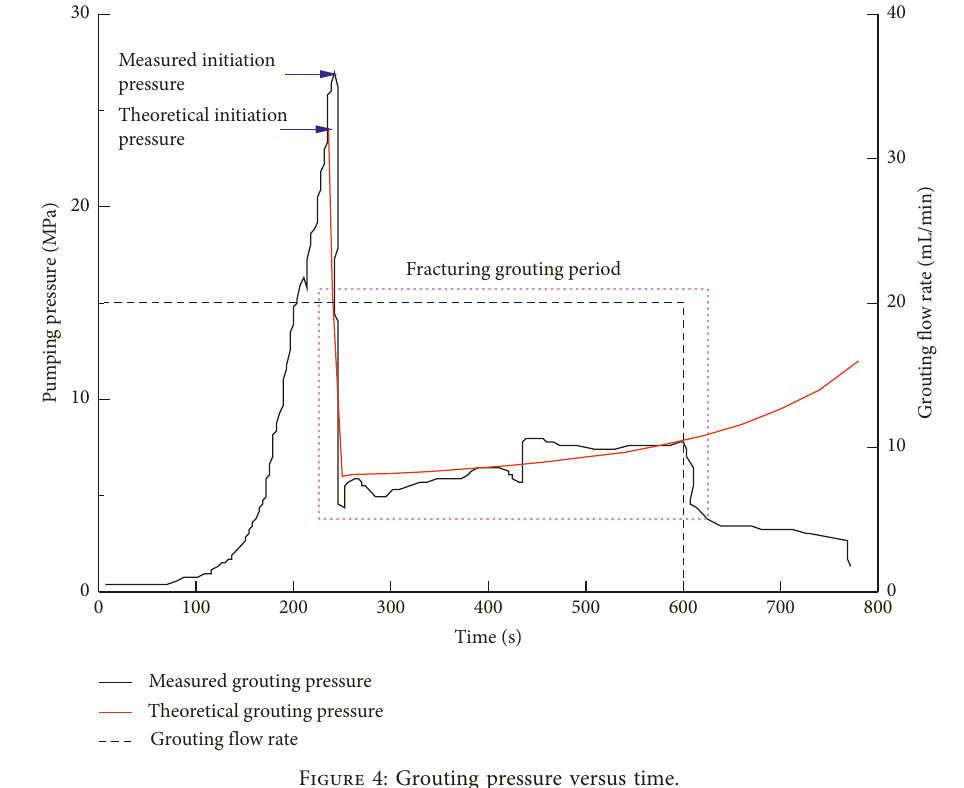
Figure 4: Grouting pressure versus time.